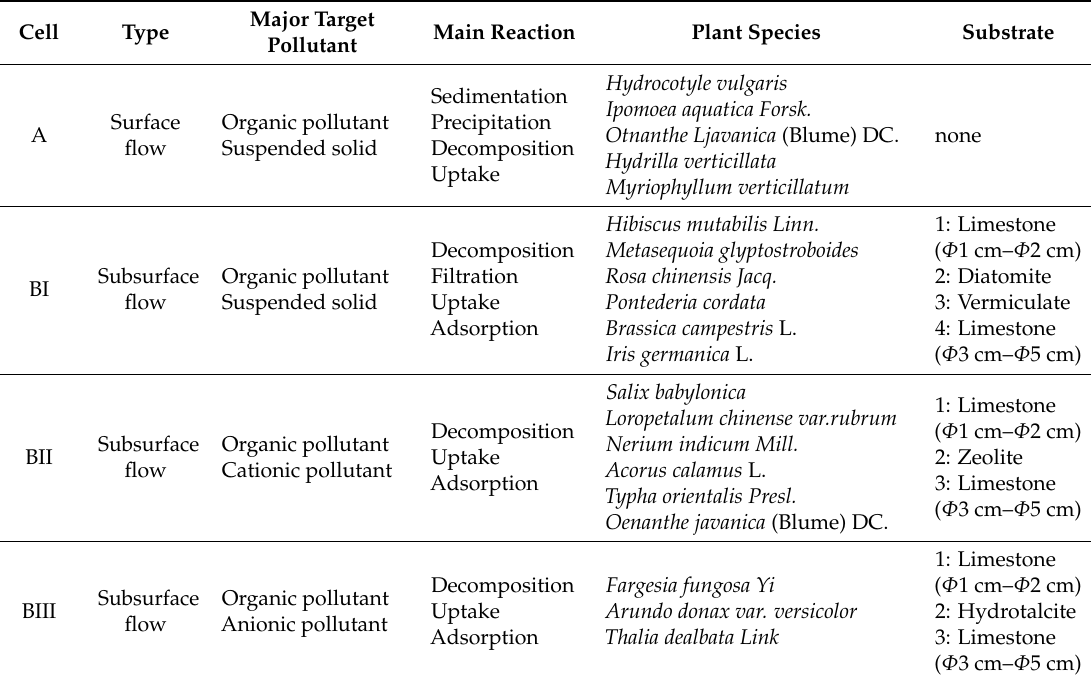
Table 1. Type, function, plant species and substrate of wetland